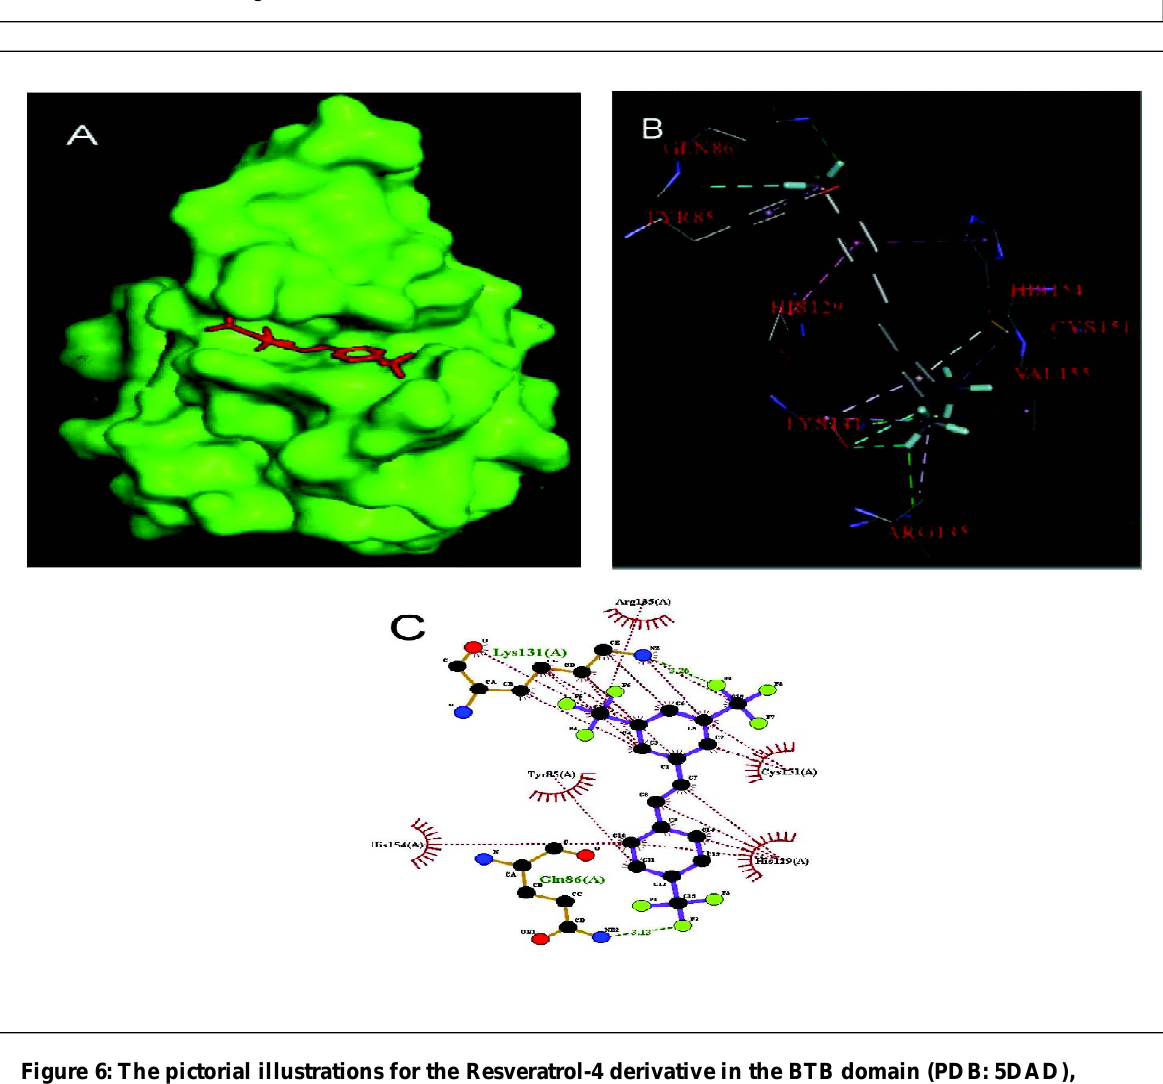
Figure 6: The pictorial illustrations for the Resveratrol-4 derivative in the BTB domain (PDB: 5DAD), including the surface view of the top-ranked docked pose (A), interaction analysis from Accelrys Discovery Studio (B) and the same from LigPlot